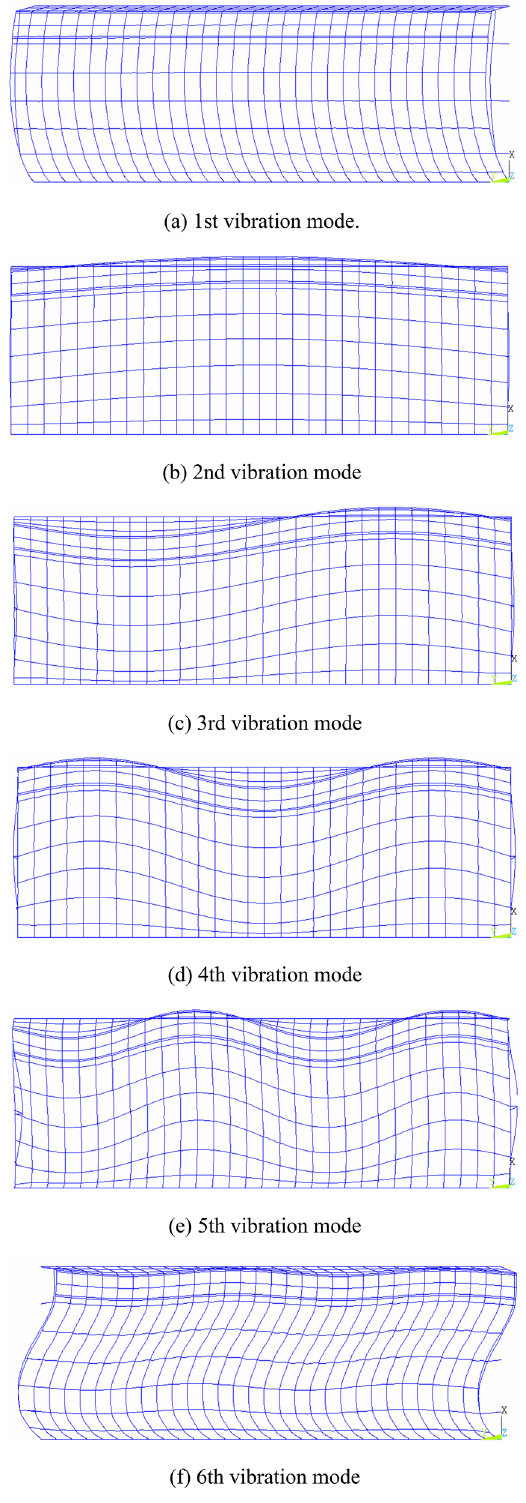
Figure 7. Six mode shapes of the